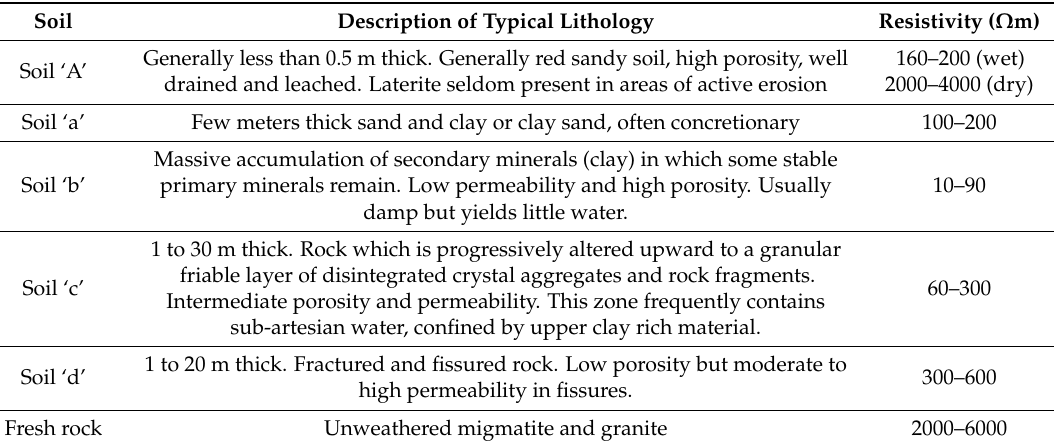
Table 1. Ranges of resistivity values for the layers of a weathered crystalline rock basement